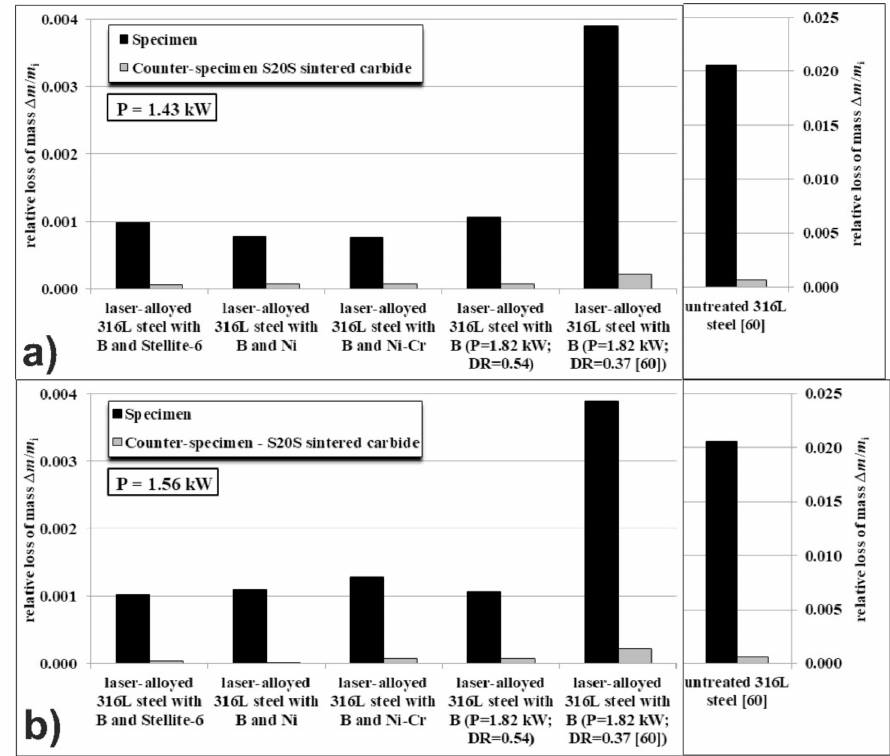
Figure 7. Results of wear tests of laser-alloyed layers with boron and selected metallic elements using the laser beam power P = 1.43 kW ( a ) and P = 1.56 kW ( b ) compared to the laser-alloyed layers with boron only at P = 1.82 kW, reported in the present study ( DR = 0.54) as well as in the paper [60] ( DR = 0.37); the relative mass loss of specimens and counter-specimens after the two-hour wear test with the change of counter-specimen at every 0.5